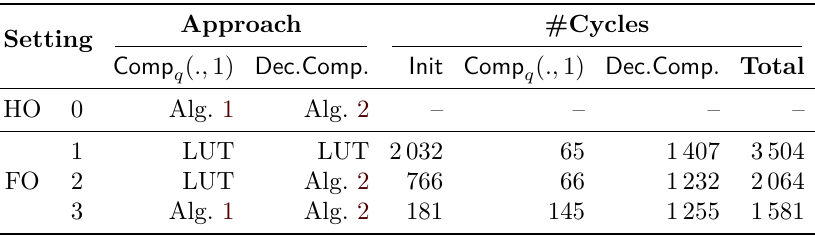
Table 1: The different LUT settings used in our first-order (FO) and higher-order (HO) implementations on the FRDM-KL82Z and their corresponding cycle counts rounded up to nearest 10 3 cycles. For first order a LUT is used for A2B , for higher orders it is not.